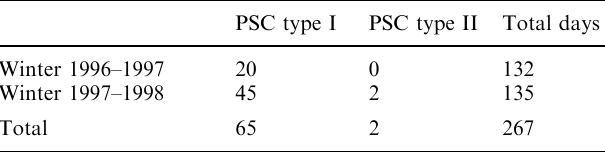
Table 5. Numbers of days with modelled PSC incidence for the winters of 1996–1997 and